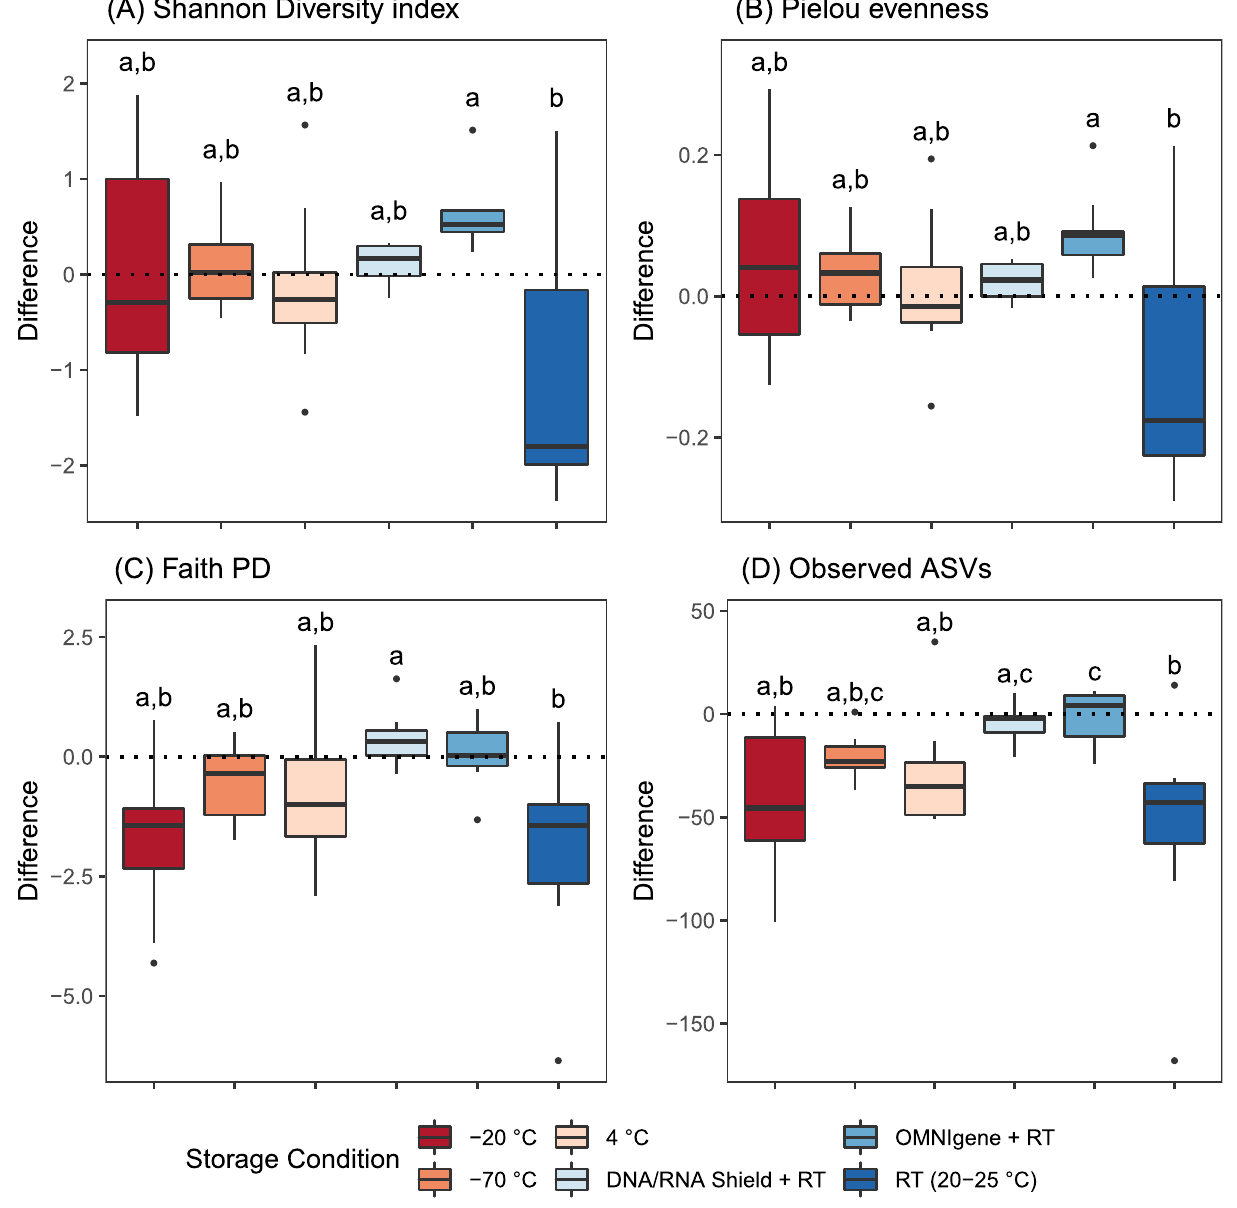
Figure 2. Pairwise differences in alpha diversity metrics between the baseline and 18 months. DNA/RNA Shield DNA/RNA shield-fecal collection tube, OMNIgene OMNIgene-Gut, RT room temperature (20–25 °C). Groups that do not share any letter denote statistical difference by the Dunn’s test at the 5% level of significance. The legend is shared across